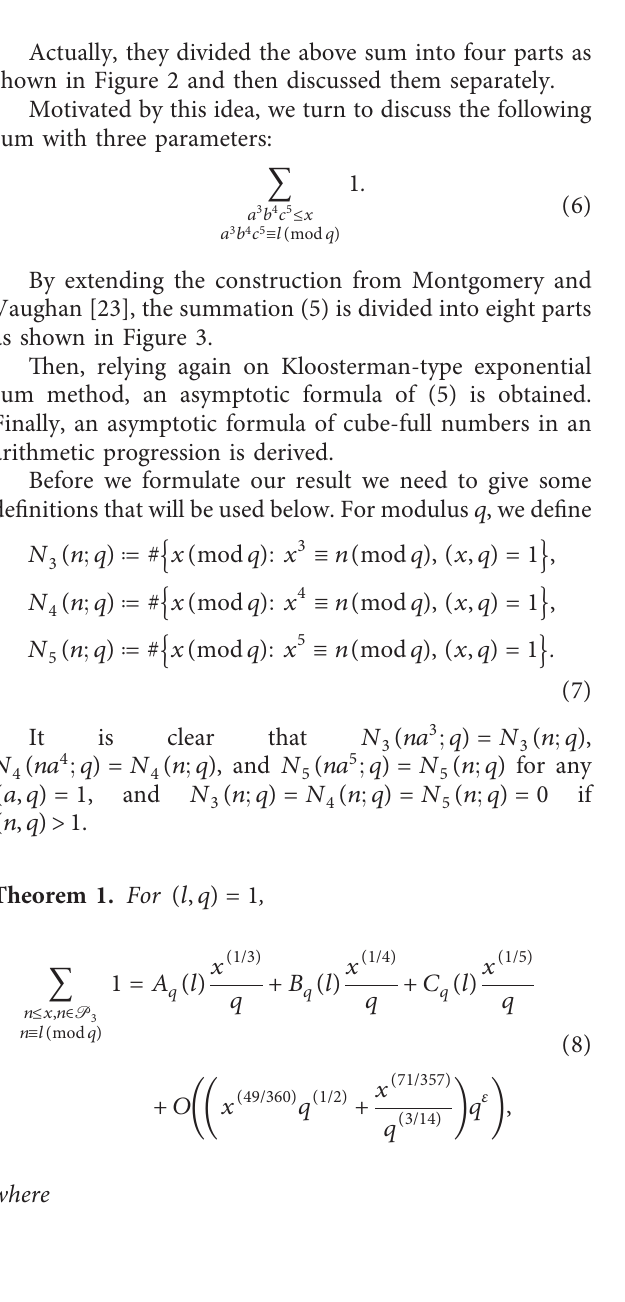
Figure 2: Generalized Dirichlet’s hyperbola method (proof of Theorem 3 in [7]).